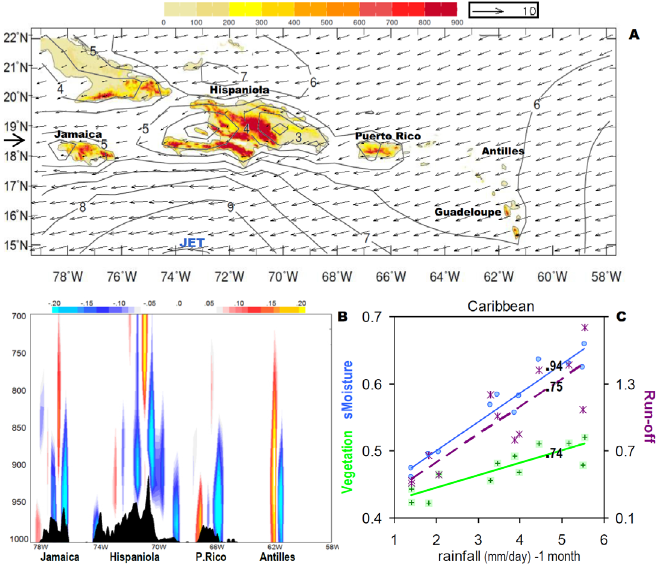
Figure 1. ( a ) Mean ECMWF5 wind vectors, speed isotachs (contour m/s) and topography (shaded). ( b ) West-